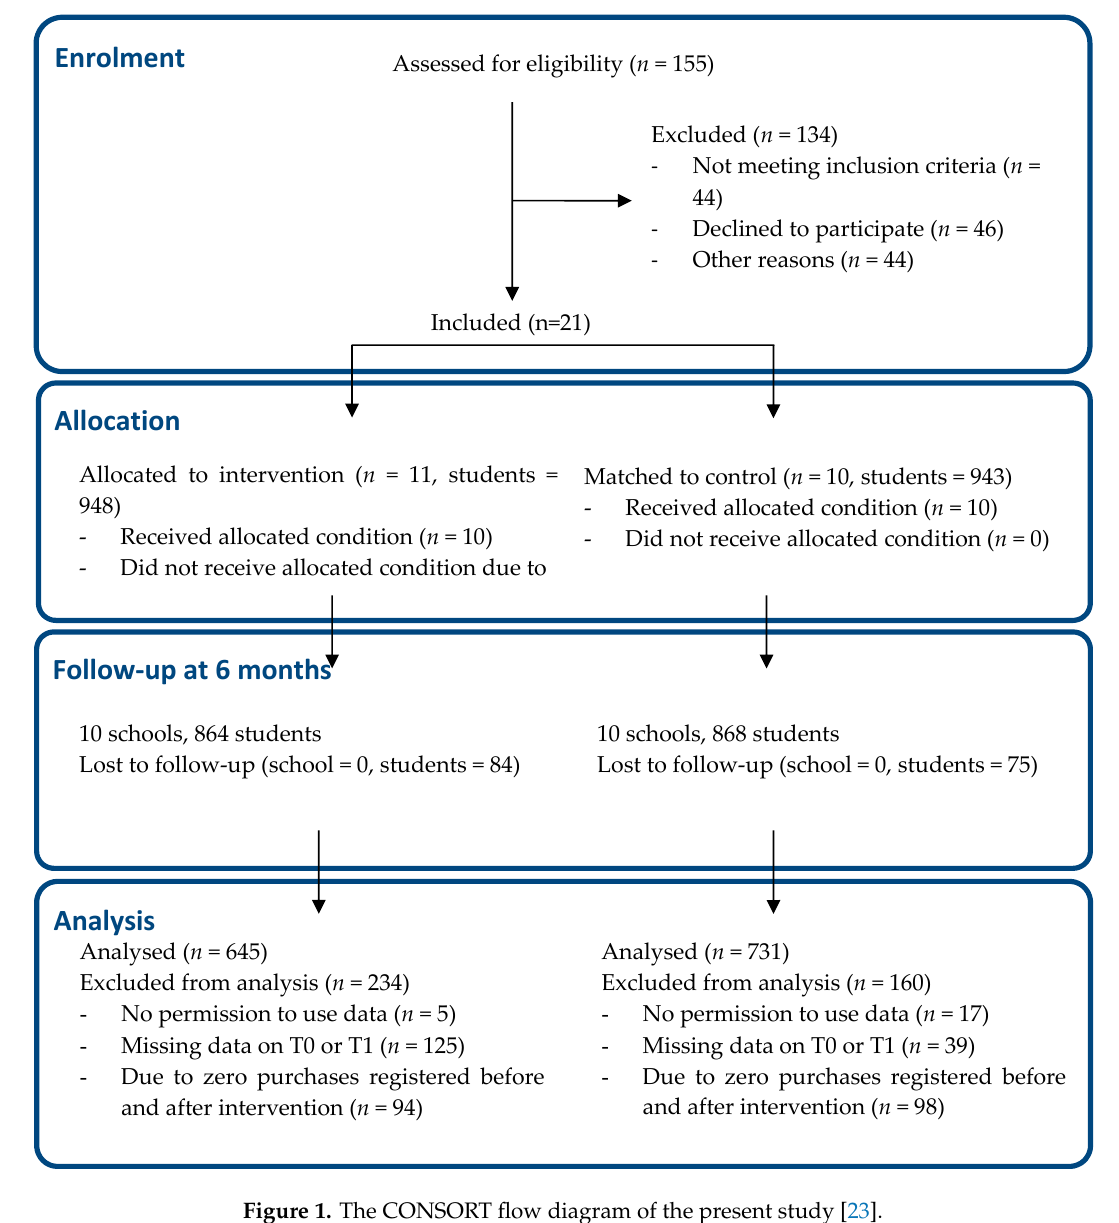
Figure 1. The CONSORT flow diagram of the present study [23].